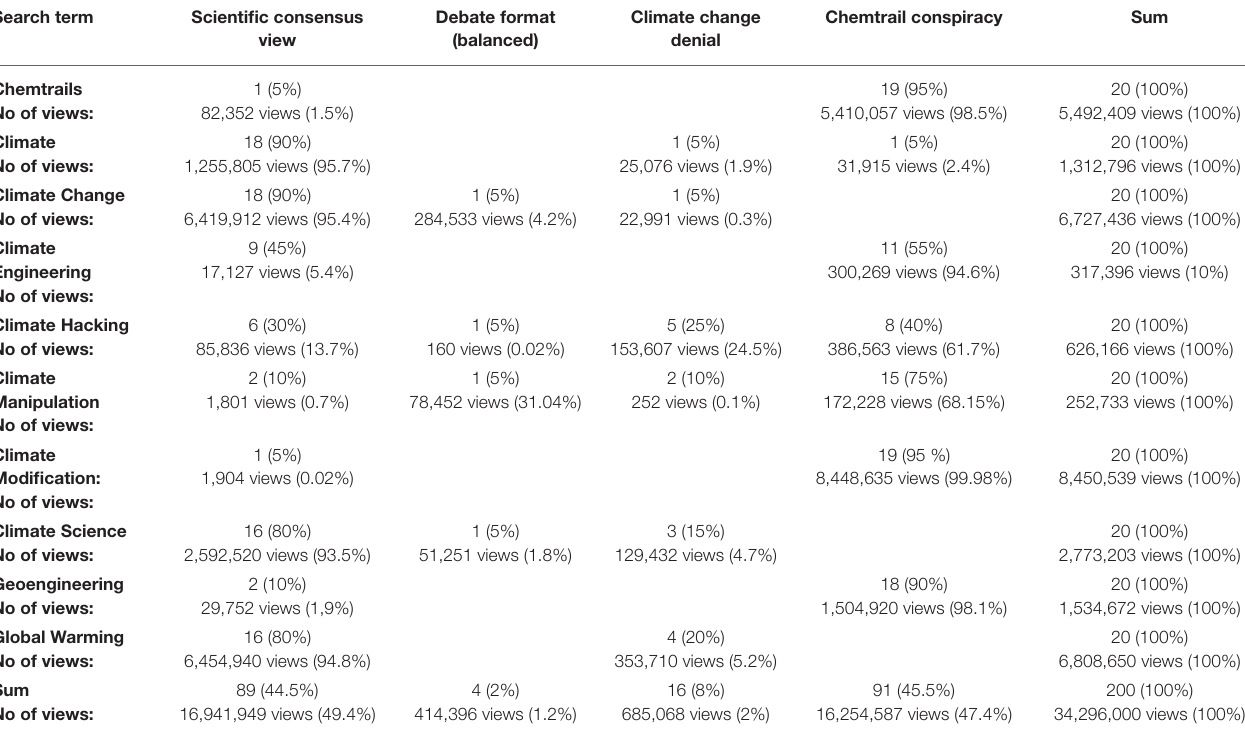
TABLE 1 | Distribution of YouTube videos in the sample ( n =